Question: Condense the content of this figure into a single sentence.
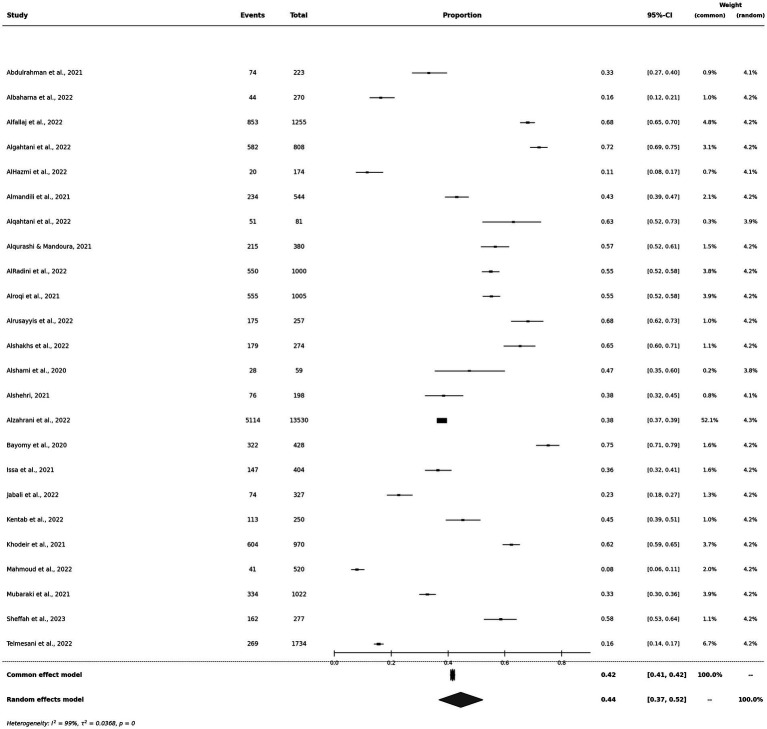
Answer: Prevalence of anosmia in patients with coronavirus disease-2019 (COVID-19) in Saudi Arabia.